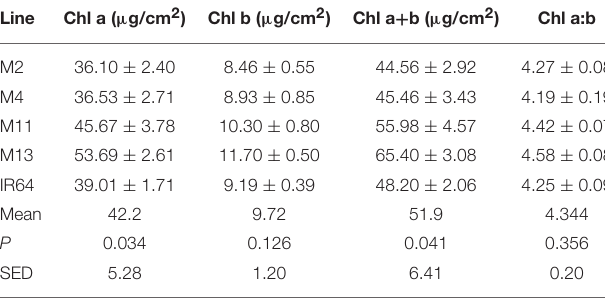
TABLE 3 | Chlorophyll content and chlorophyll a:b ratio at GS2 (85 DAT), top of